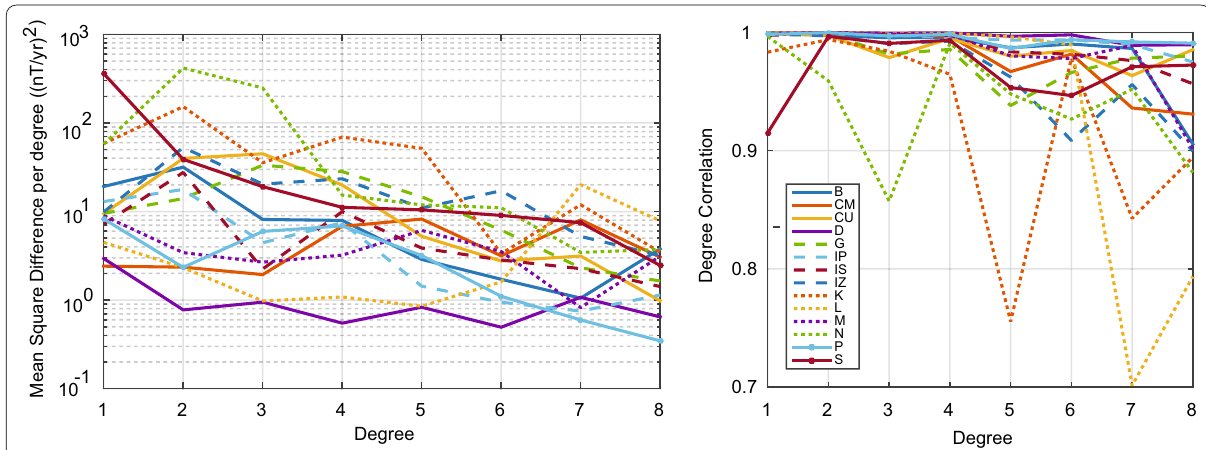
Fig. 8 Power spectral differences (left) and degree correlation (right) between the SV-2020-2025 candidates and the robust